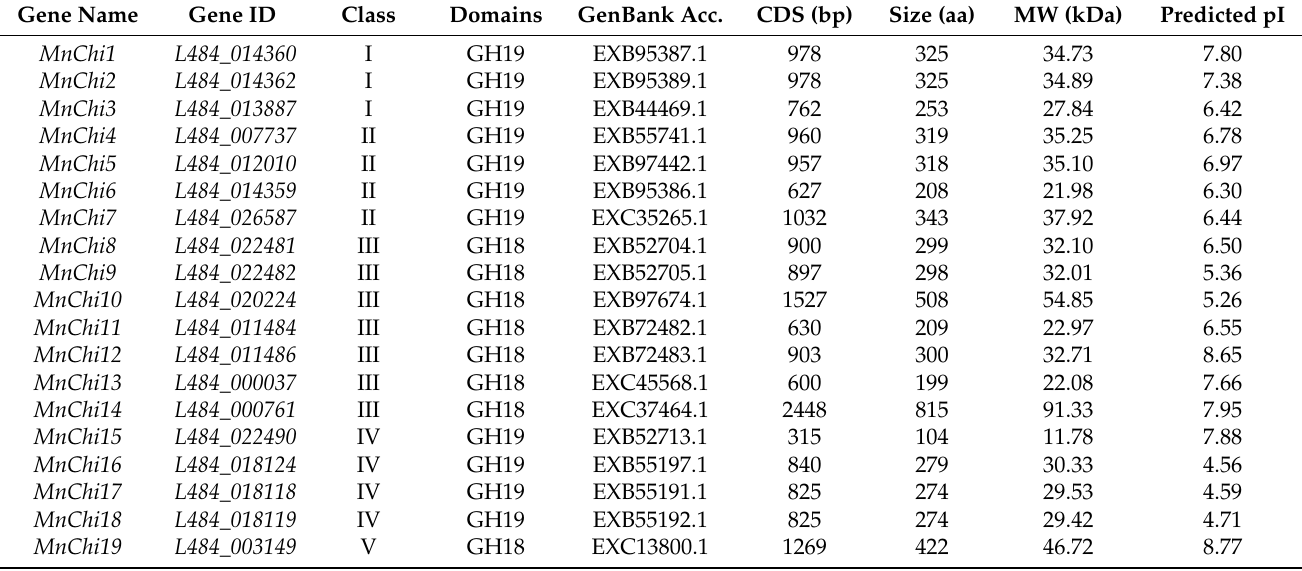
Table 1. Characterization of the chitinases in M. notabilis